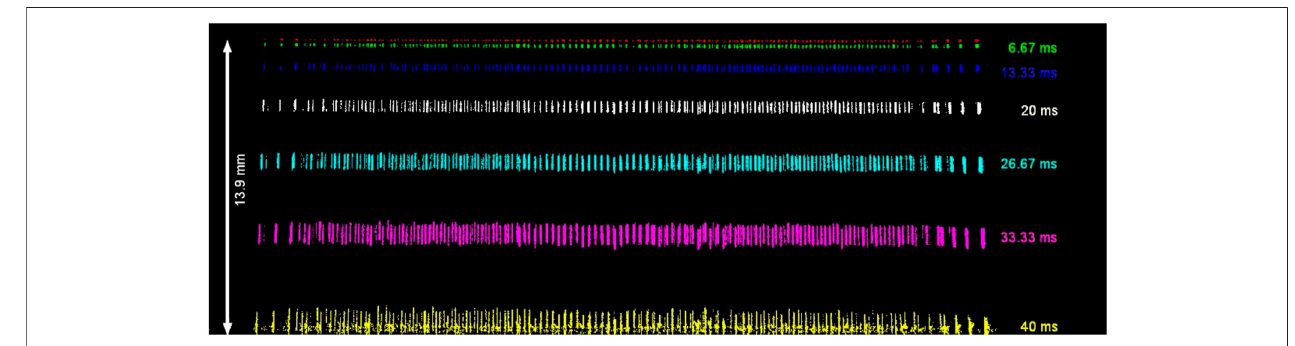
FIGURE 2 | Side-view images of falling microspheres. Shown here is a superposition of every fourth image recorded during the fall. This result reveals that the motion is mainly a downward acceleration, with a slight outward displacement, which are quanti fi ed in the main text. The top-most image was recorded at t = 0, which was the moment that the radio-frequency power was switched off; the other images were recorded at later times, as indicated in the legend.